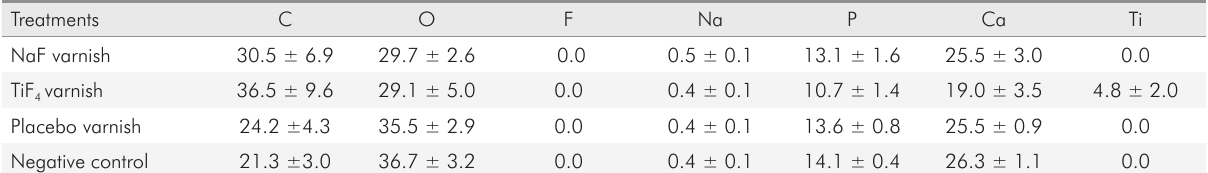
Table 2. EDS analysis of the surface of enamel blocks; chemical elements are shown according to the treatments (means ± standard